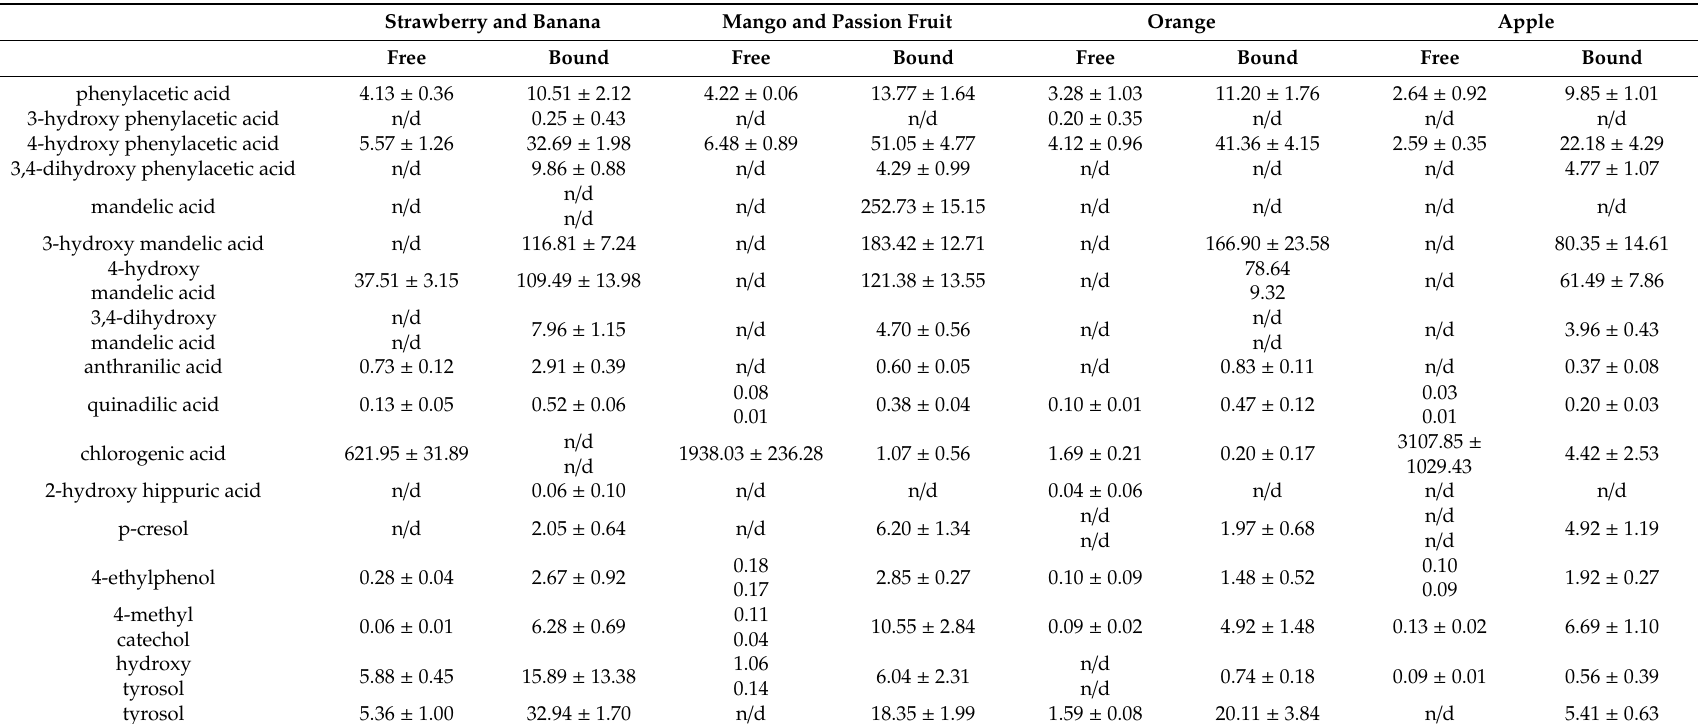
Table 4. Phenylacetic acid, mandelic acid, and other phenolic metabolite content of juice / smoothie